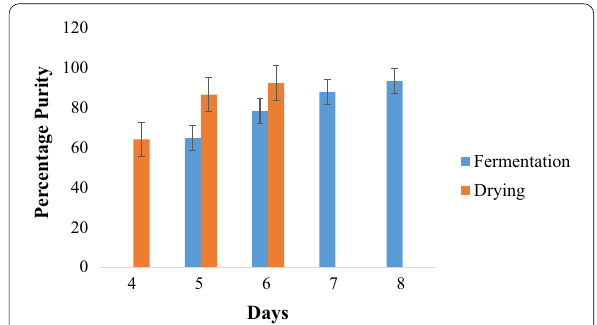
Fig. 4 Levels of cocoa bean purity as influenced by different fermentation and drying durations